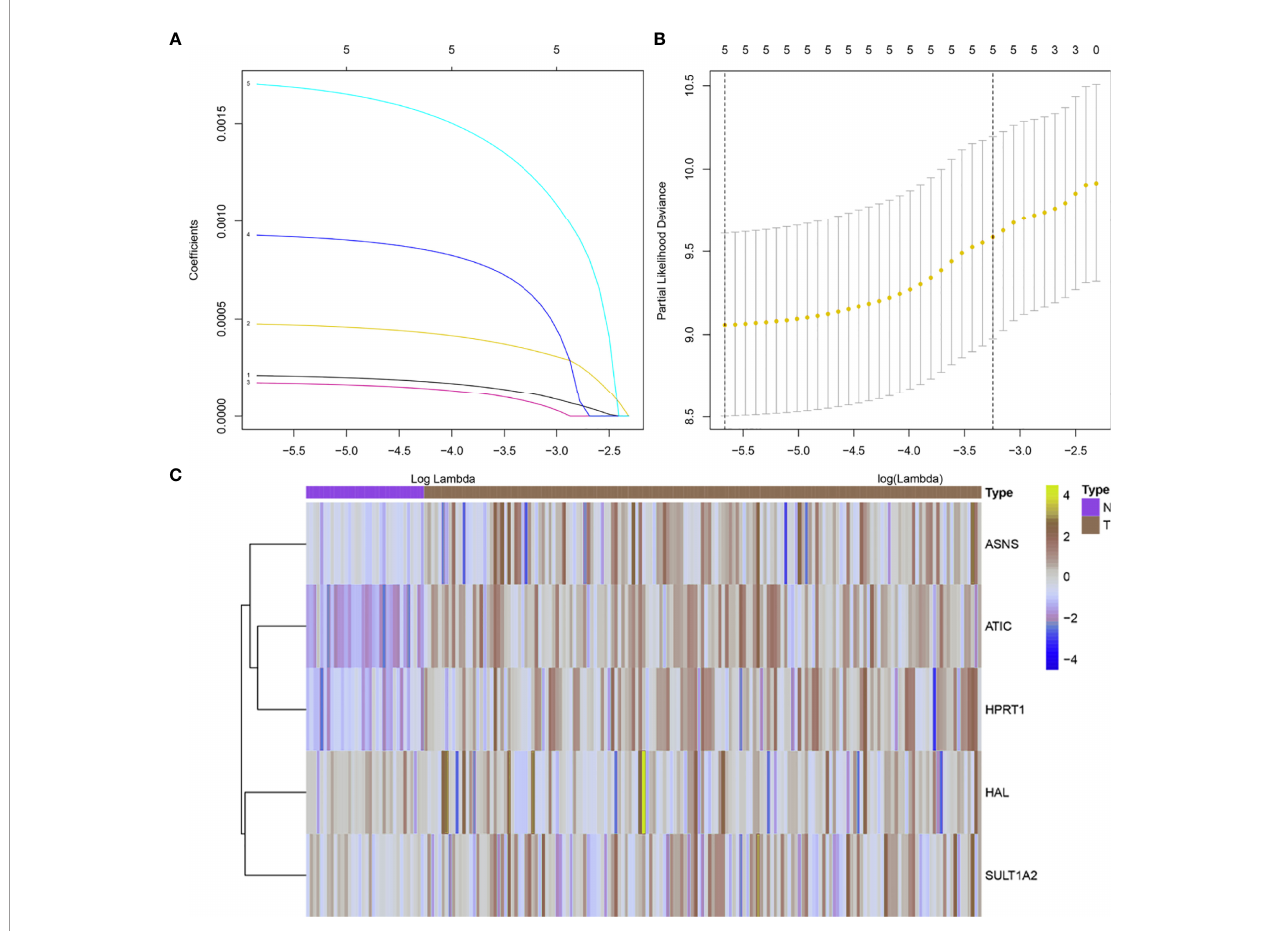
FIGURE 3 | 5 metabolism-related genes were identi fi ed for construction of the risk scoring system. (A) Validation was performed for tuning parameter selection through the LASSO regression model; (B) Elucidation for LASSO coef fi cient pro fi les of prognosis-related genes; (C) A heat map showing the expression of 5 metabolism-related genes. A total of 156 HER2-positive samples were analyzed